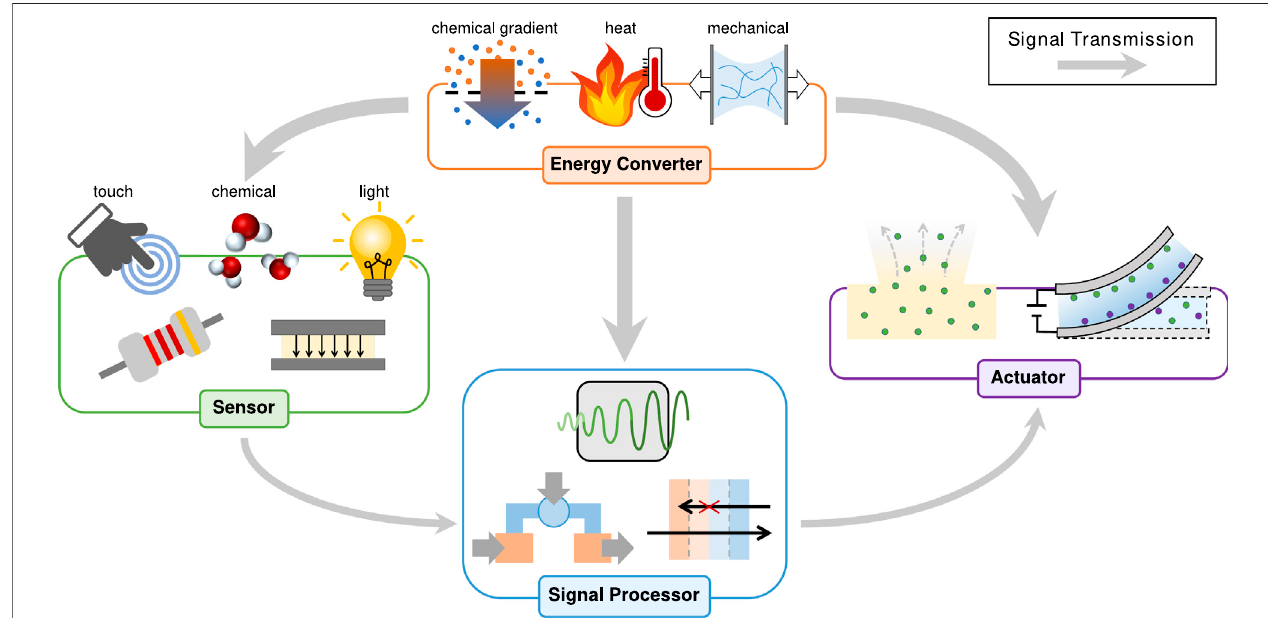
FIGURE1| Overviewoffunctionscommonlyneededforafreestandingionicdevice,howtheyinteractwitheachother,andexamplewaysthedevicewouldinteract with the external world.